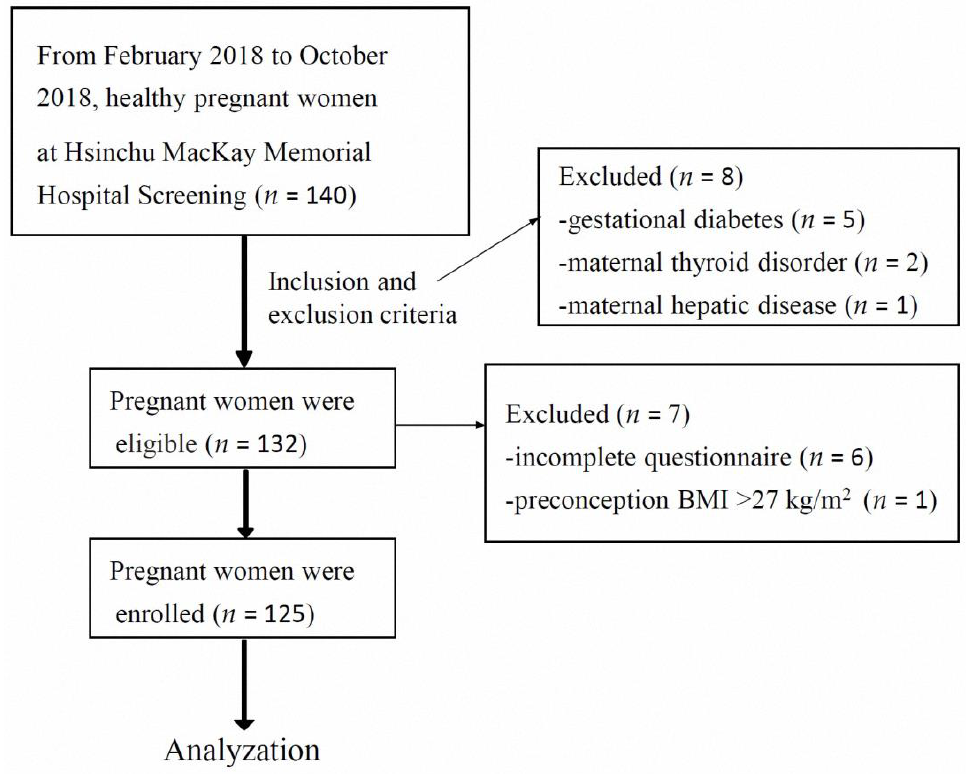
Figure 1. Flowchart of this study. Altogether, 140 pregnant women were recruited; of these, 125 were enrolled and completed the study